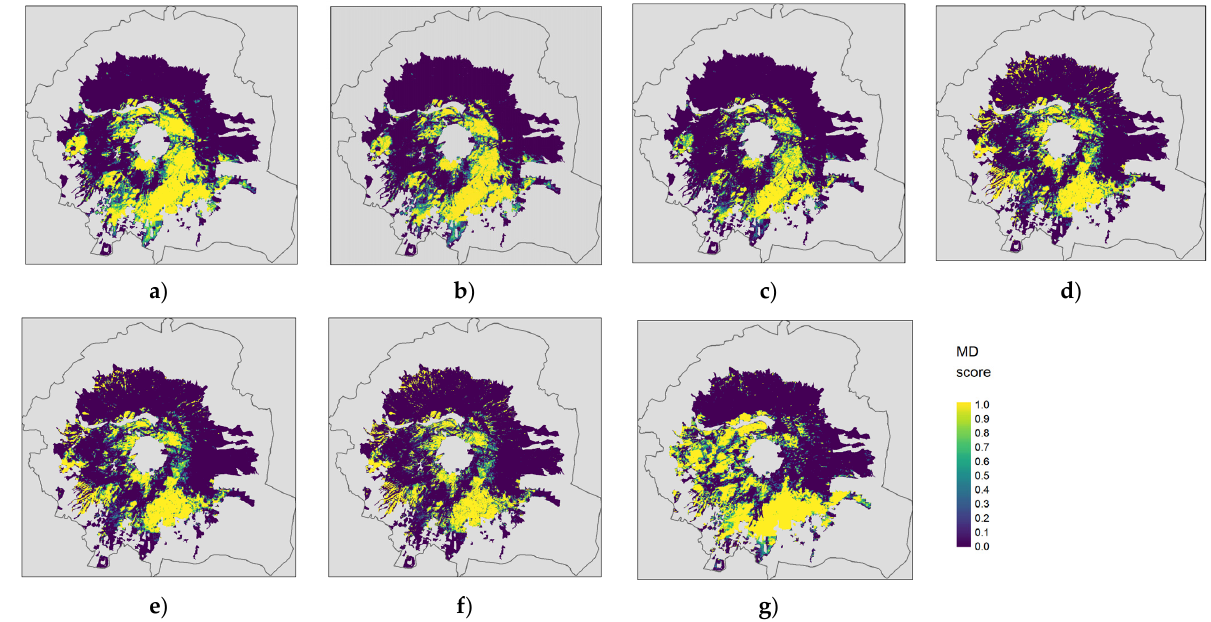
Figure 6. Partial evidence of burn as given by the input features interpreted by sigmoid MFs: Post RE2 ( a ), Post RE3 ( b ) Post NIR ( c ), Δ RE2 ( d ), Δ RE3 ( e ), Δ NIR ( f ) and Δ SWIR2 ( g ). Color scale shows increasing degree and likelihood of burn (blue to yellow).